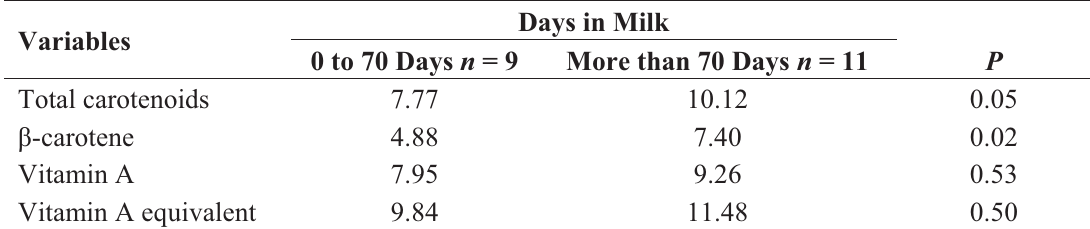
Table 6. Carotenoid and Vitamin A contents ((cid:4)g/g of fat) of milk produced at the initial and median phase of lactation by cows on pasture supplemented with GC or CC.